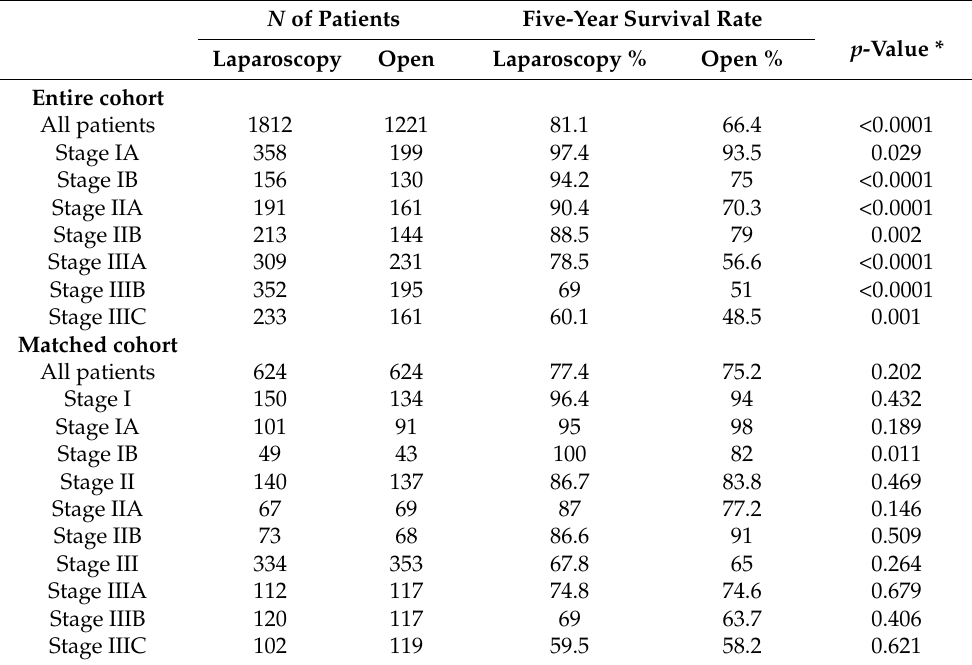
Table 4. Five-year cumulative overall survival (stratified by AJCC pTNM stage, 8th edition) in laparoscopic and open